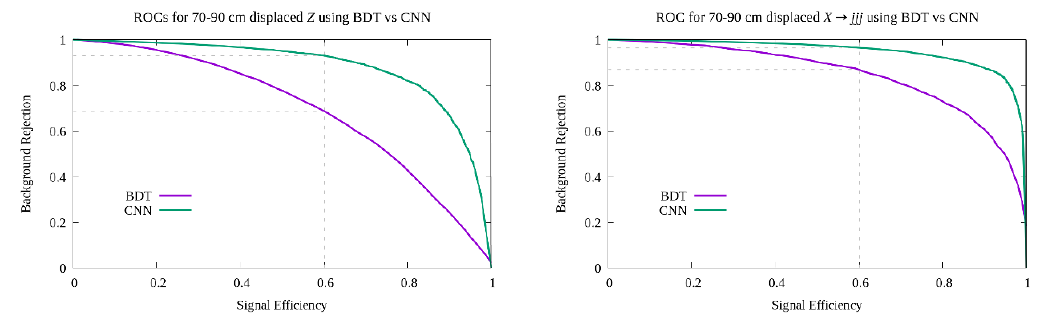
Figure 12. CNN vs BDT: comparison of performance for both